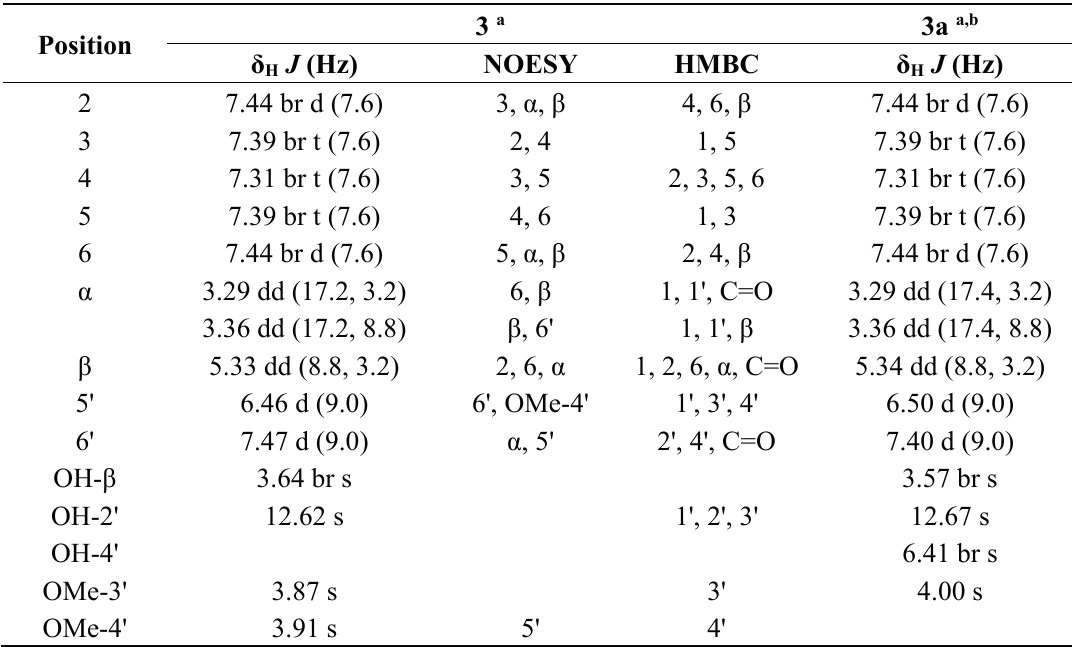
Table 3. 1 H-NMR data of 3 and 3a